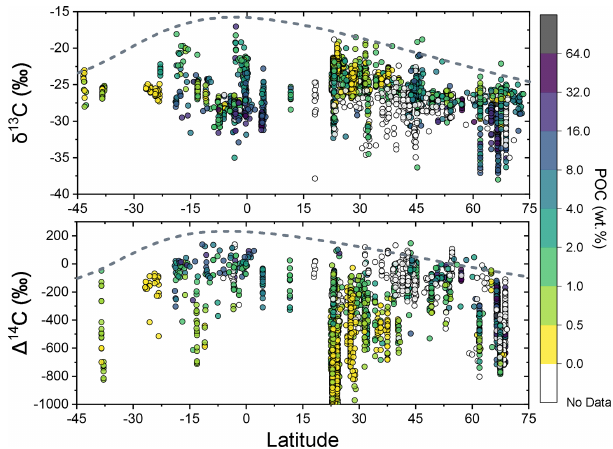
Figure 3. Latitudinal trends in δ 13 C ( n = 3204) and (cid:49) 14 C ( n = 2212) in MOREPOC v1.1. Colors indicate POC content (wt%). Dotted lines represent upper envelopes of δ 13 C and (cid:49) 14 C values of